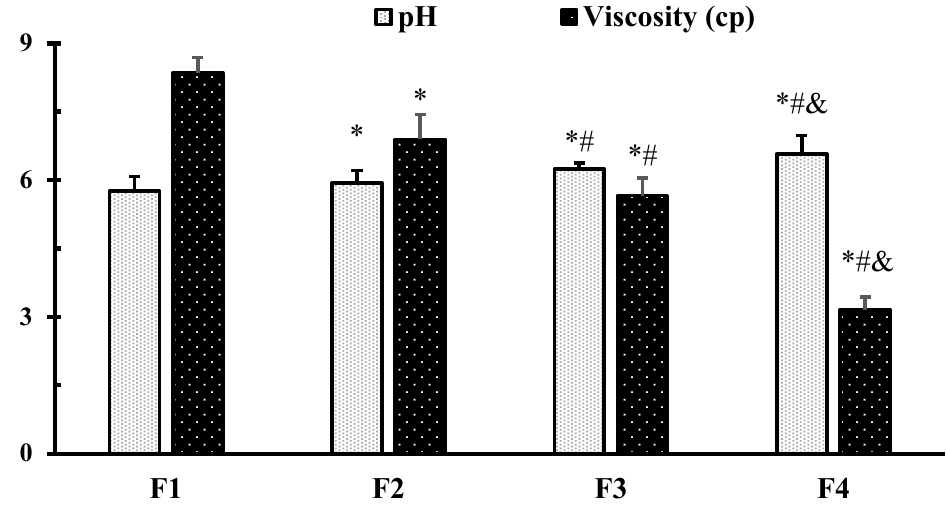
Figure 2. The pH and viscosity of hemp seed oil nanoemulsion formulations. *: versus formulation 1 (F1), #: versus F2, and &: versus F3 at p < 0.05.